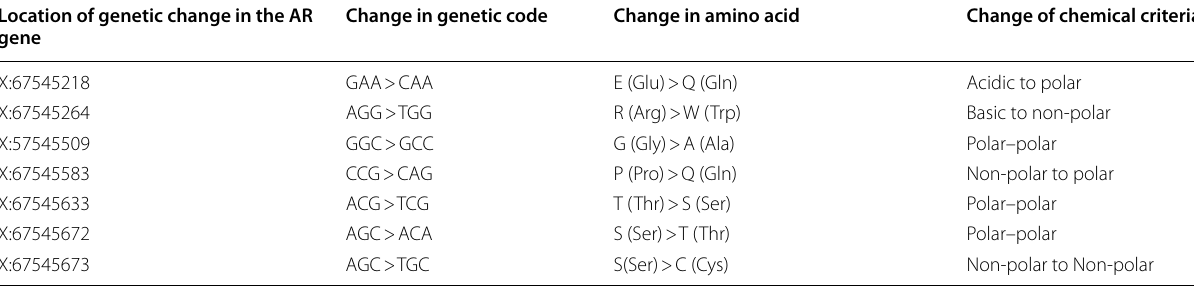
Table 3 Location, genetic code change, and effect on amino acid sequence in patients with PCOS Location of genetic change in the AR Change in genetic code Change in amino acid Change of chemical gene